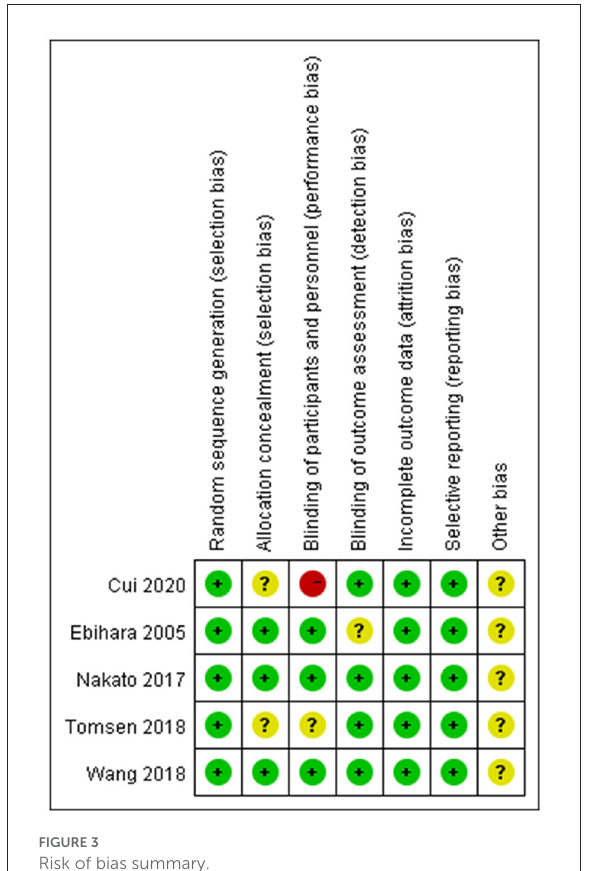
FIGURE3 Risk of bias